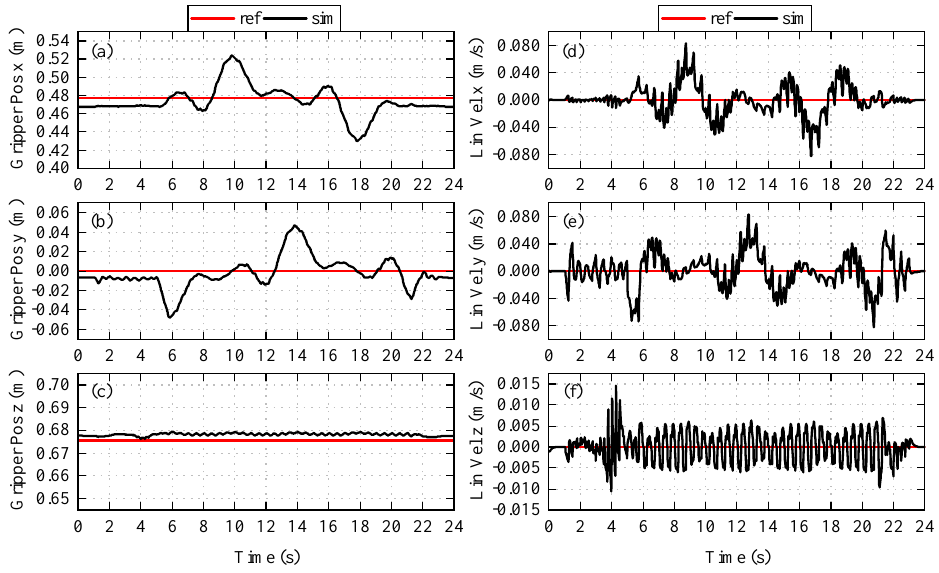
Figure 6. Gripper position and linear velocity. Graphs ( a – c ) are position tracking in the x-, y-, and z-direction. Graphs ( d – f ) are linear velocity tracking and these velocities are expressed in the world